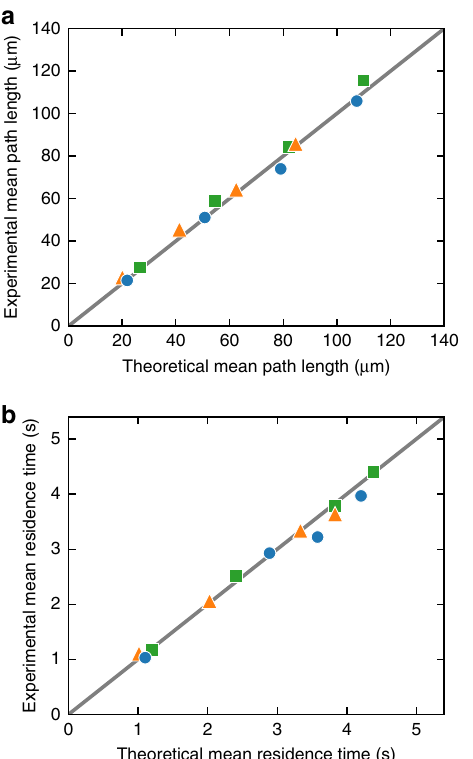
Fig. 3 Invariance in structures with different size and shape. a Experimental vs theoretical mean path lengths. Each shape is represented by the corresponding symbol (circle, square, triangle) appearing four times, one for each of the four sizes in Fig. 2. All structures contains obstacles with the same density. The line passing through zero represents perfect agreement between theory and experiments. b Same as a for the mean residence